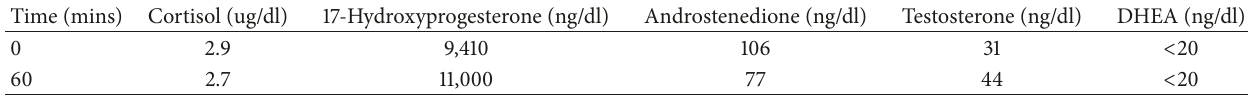
Table 1: Results of high dose ACTH stimulation test with 250 mcg